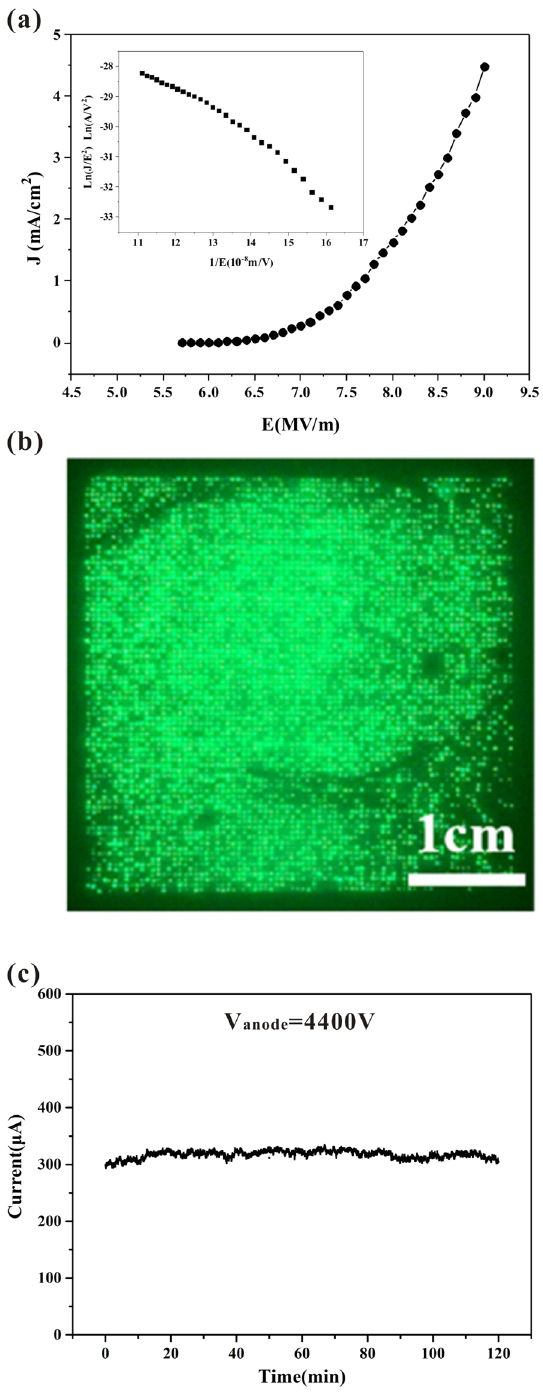
Figure 3. Field-emission characteristics of the ZnO nanowire arrays: ( a ) Field emission J - E curve, where the corresponding F-N plot is shown in the inset; ( b ) the field emission image; ( c ) the field emission current versus time (I-t)